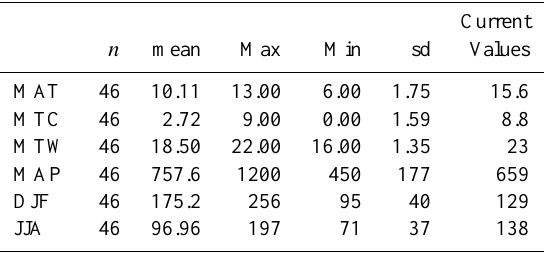
Table 4. Relation of temperature and precipitation for Canyars. MAT, mean annual temperatures; MTC, mean temperature of cold- est month; MTW, ,mean temperature of warmest month; MAP, mean annual precipitation; DJF, mean winter precipitation; JJA, mean summer precipitation; n , number of intersection points; Max, maximum of values obtained; Min, minimum of values obtained; Mean, mean of values obtained; SD, standard deviation of values obtained. Current values have been obtained from the Barcelona Airport meteorological station (data from Font-Tullot,